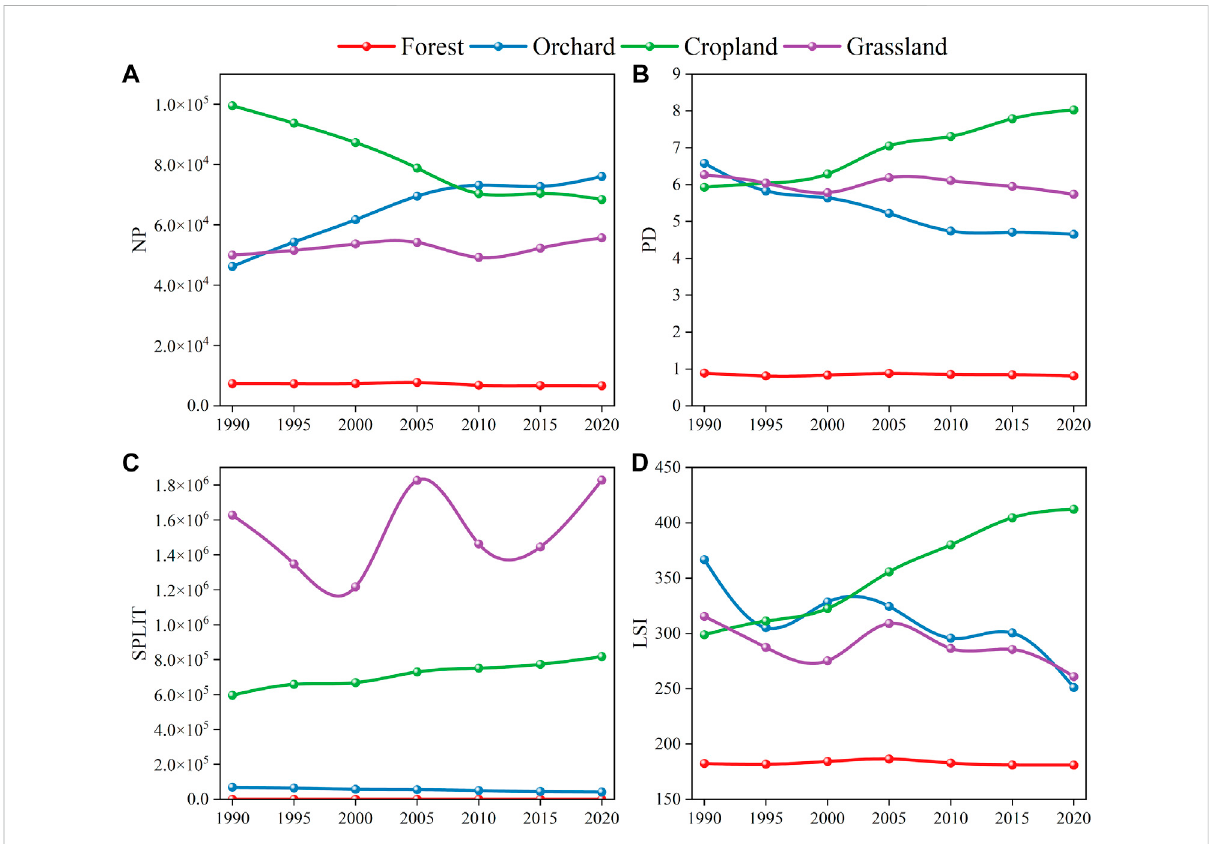
FIGURE 9 Evolution landscape metrics of different land use. Four landscape metrics were selected, including NP, PD, SPLIT and LSI. (A – D) Shows the evolution results of four land use types, including forest, orchard, cropland and